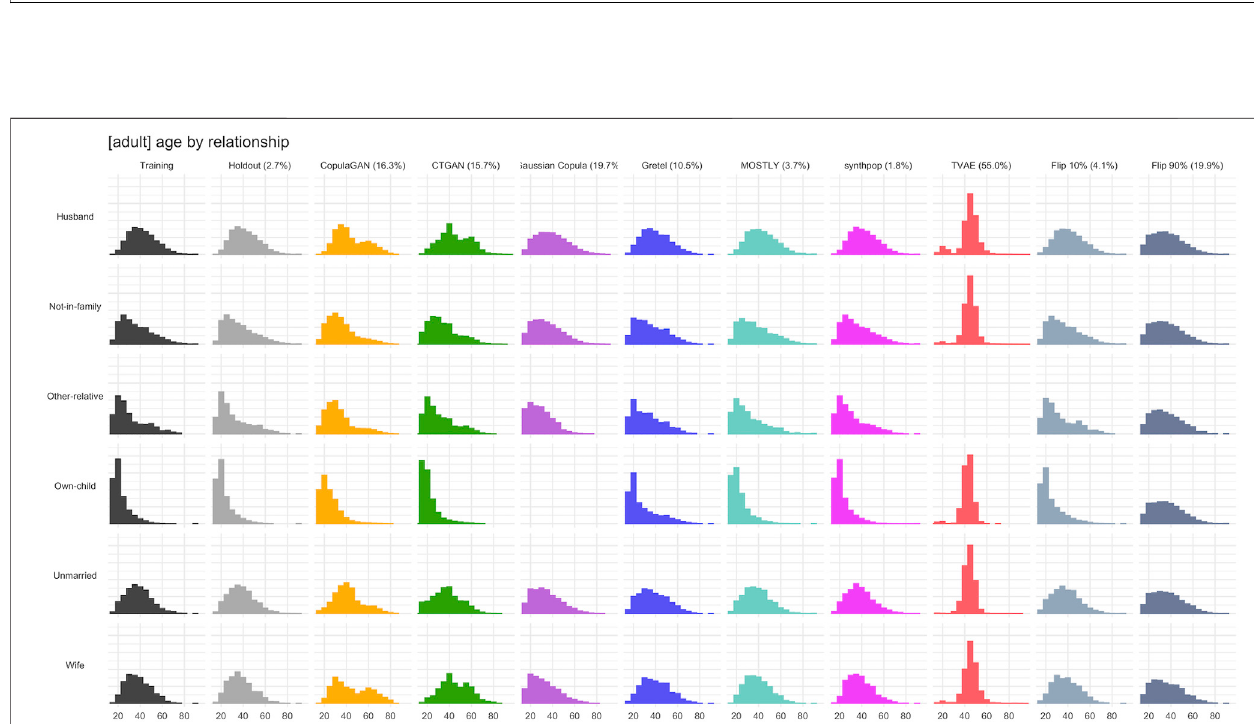
FIGURE 7 | Selected bivariate marginal distribution for dataset “ adult ” across synthesized data and across perturbated data. Their total variation distance (TVD) with respect to the training set, displayed as percentages in brackets, contribute to the respective F 2 fi delity measure.